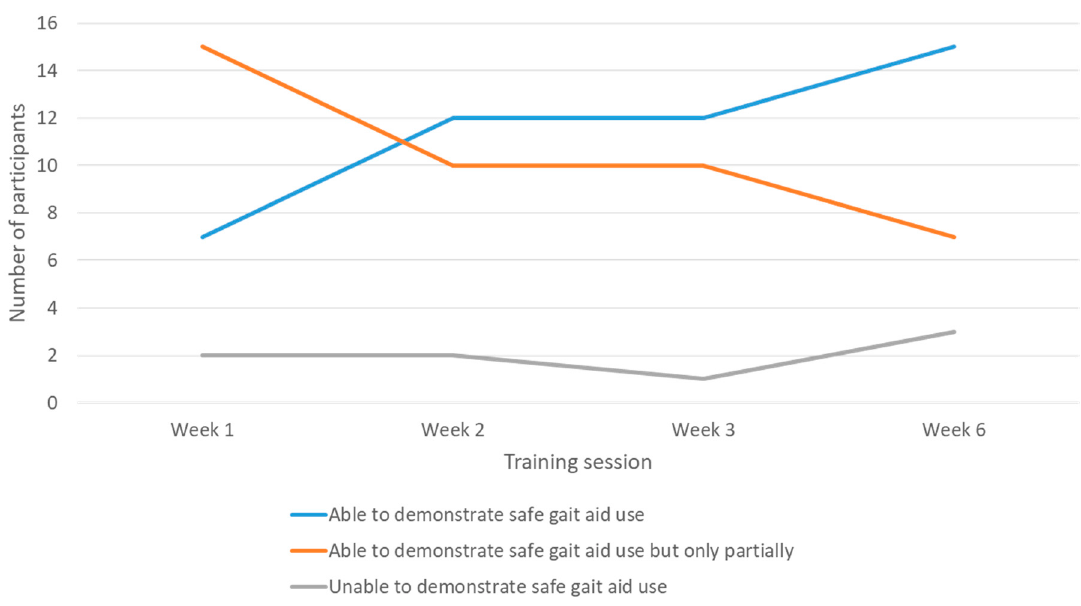
Figure 2. Study physiotherapists’ clinical judgement on achievement of safe gait aid use by partici- pants at each training session.